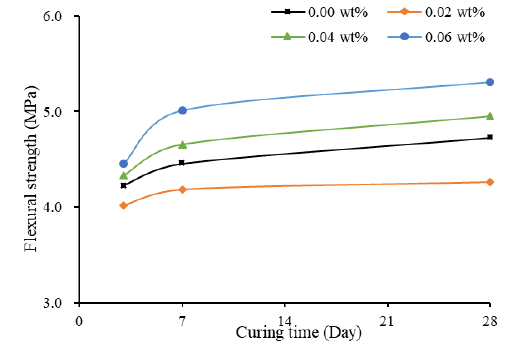
Figure 11. Flexural strength of TX10-added mortar prisms.